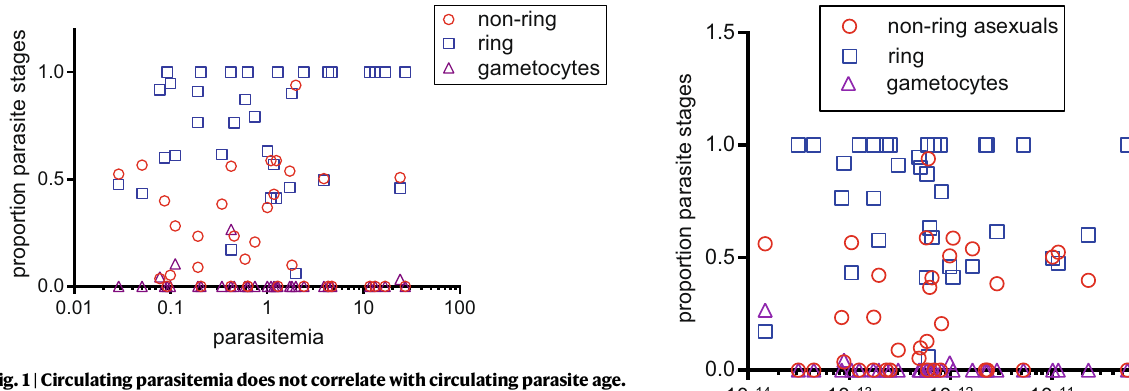
Fig.1|Circulatingparasitemiadoesnotcorrelatewithcirculatingparasiteage. Parasitemias for the 16 severe malaria samples and 19 uncomplicated malaria samples that were used for the differential gene expression analysis of the full transcriptome are plotted against the proportion of the circulating parasites esti- mated by our mixture model that were ring stages, asexual non-ring stages and gametocytes 1 . Source data are provided as a Source Data fi le.